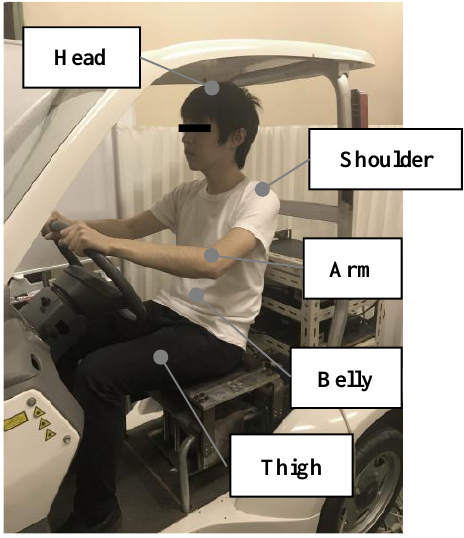
Figure 14. Measuring points of acceleration. Table 2. Peak of the transfer function in each part of the human body.